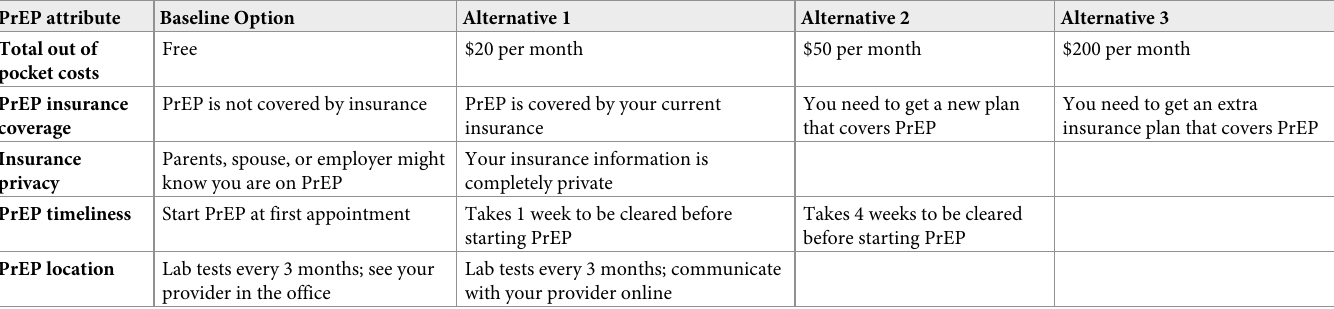
Table 1. Possible attributes for PrEP choice